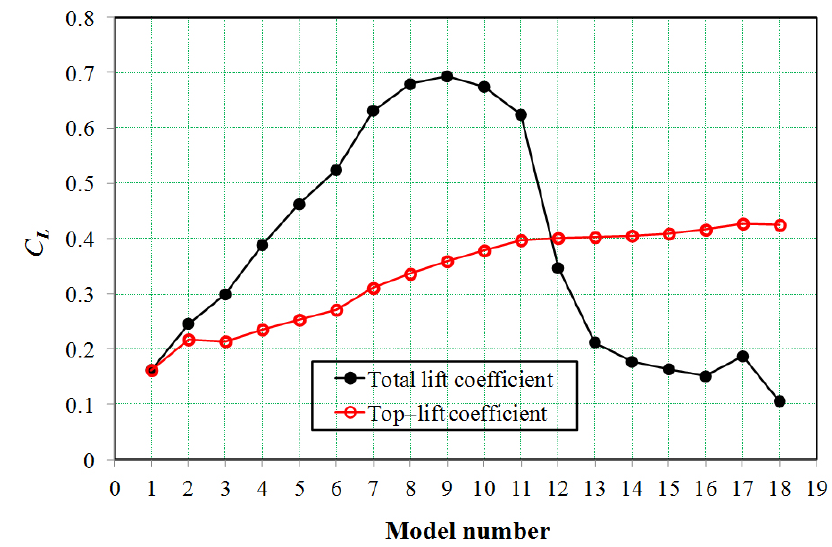
Figure 13. Variations in lift coefficient with the model number.